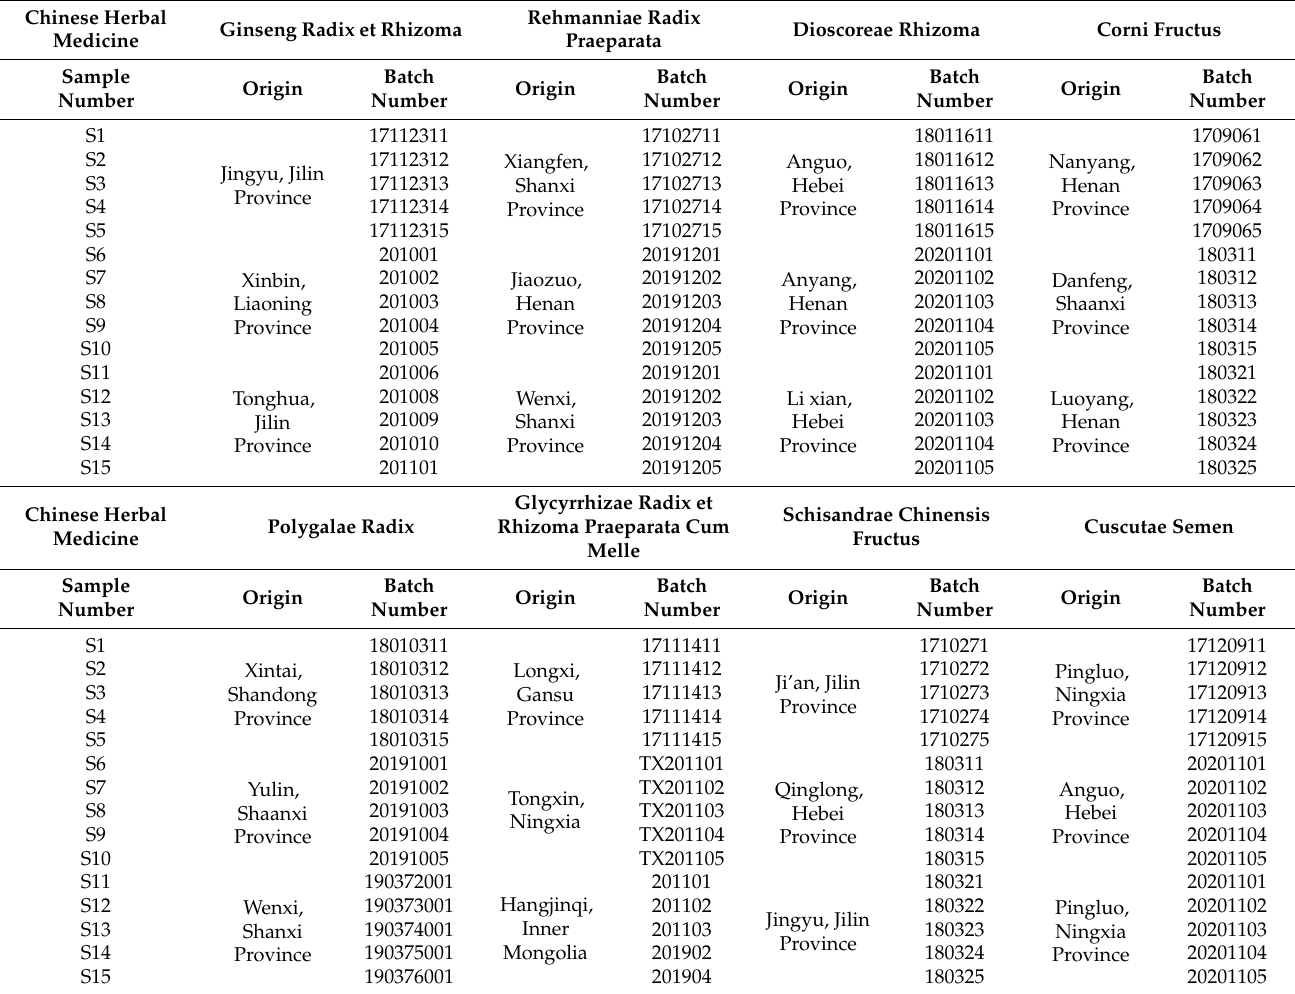
Table 9. Origin and batch numbers of the Chinese herbal medicines in the fifteen batches of GYJ samples